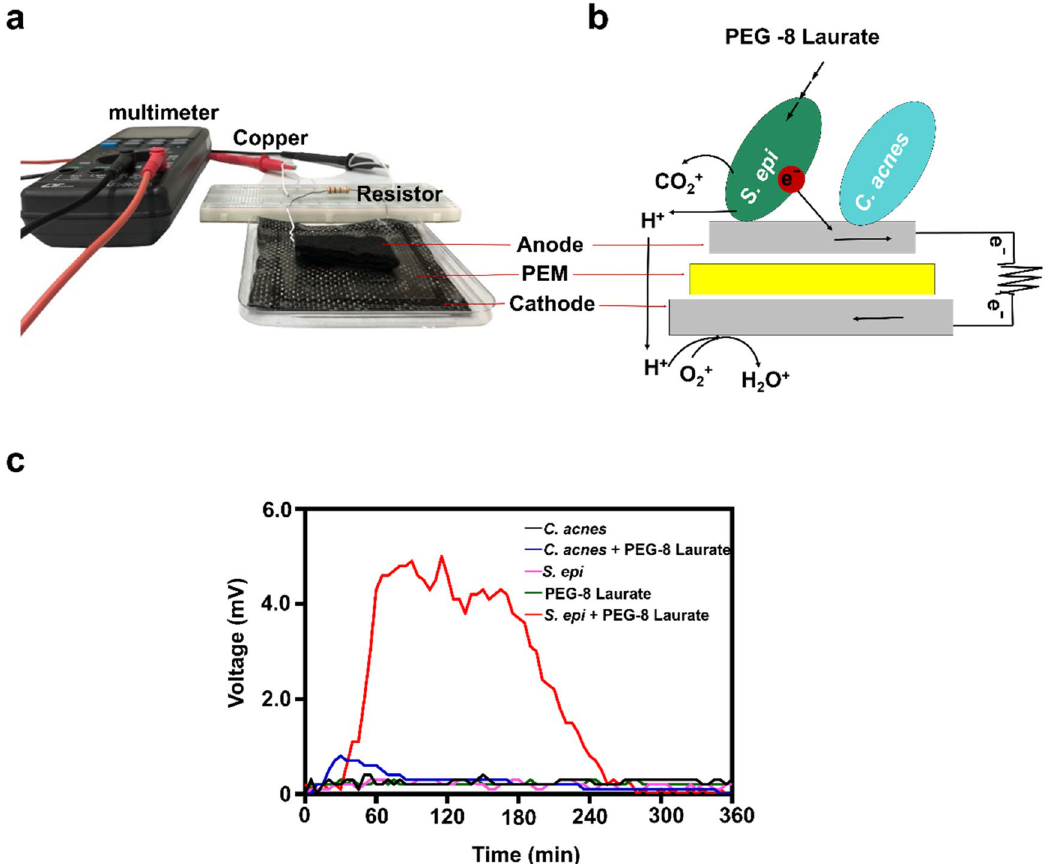
Figure 1. PEG-8 Laurate triggered S. epidermidis to produce electricity measured by voltage changes. ( a ) The surface of anode (a carbon felt) was spotted with S. epidermidis ATCC 12228 ( S. epi ) (10 7 CFU) or C. acnes ATCC 6919 (10 7 CFU). PEM (a nafion membrane) was used to separate the anode and cathode (a carbon cloth) which were connected via copper wires to a conductive resister. The mV was detected by a digital multimeter. ( b ) Schematic of diagram represented in vitro detection of bacterial electricity. Electrons produced by S. epidermidis in the presence of PEG-8 Laurate on anode were transferred to cathode. ( c ) The voltage difference (mV) between anode and cathode in the presence of S. epidermidis or C. acnes with or without PEG-8 Laurate was monitored for 360 min. Illustration ( a , b ) is from own